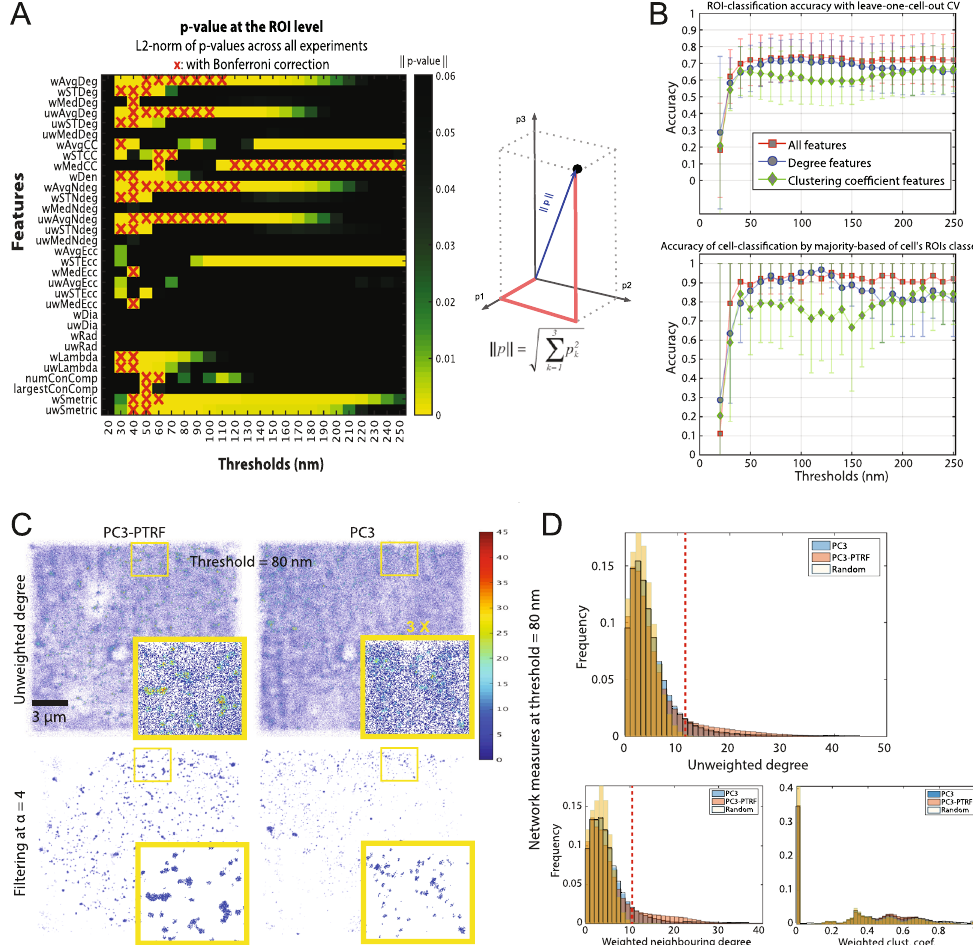
Figure 3. Multi-threshold analysis of PC3 and PC3-PTRF data at the ROI level. ( A ) Multi-threshold statistical analysis shows network measures and thresholds that discriminate PC3 and PC3-PTRF 3D point clouds. For each experiment, the p-values are calculated by the two-sided non-parametric Mann-Whitney statistical test to evaluate the null hypothesis that the network measures of the two populations (PC3 and PC3-PTRF) followed the same distribution. p-values ( p 1 , p 2 , and p 3 ) from Experiments 1–3 (see Fig. 1B) are aggregated via the L2- norm. We show the results with and without Bonferroni multiple comparisons correction. ( B ) Random decision forest accuracy of classifying the two populations at ROI (top) and cell level (bottom) using the whole feature set (red), degree features only (blue), and clustering coefficient features only (green). The error bars represent the standard deviation. ( C ) Filtering-out noisy blinks using unweighted degree at 80 nm via comparison with random graphs. ( D ) Filtering-out noisy blinks at 80 nm for unweighted degree, weighted neighboring degree (significant) and weighted clustering coefficient (non-significant). Vertical dashed red lines indicate level of noise removal. See Figs S2,